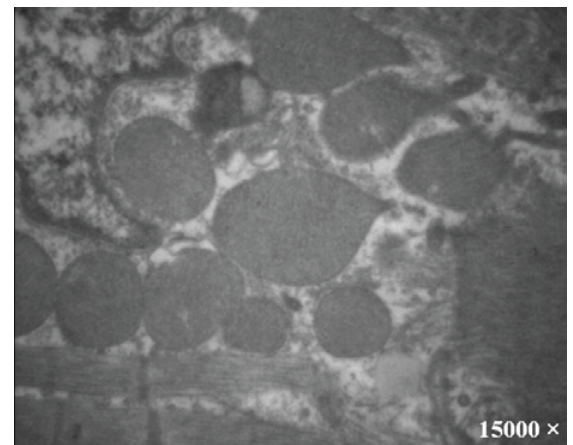
Figure 4. Electron micrographs of heart muscles of defibrillated dogs. Note that the mitochondria is intact.